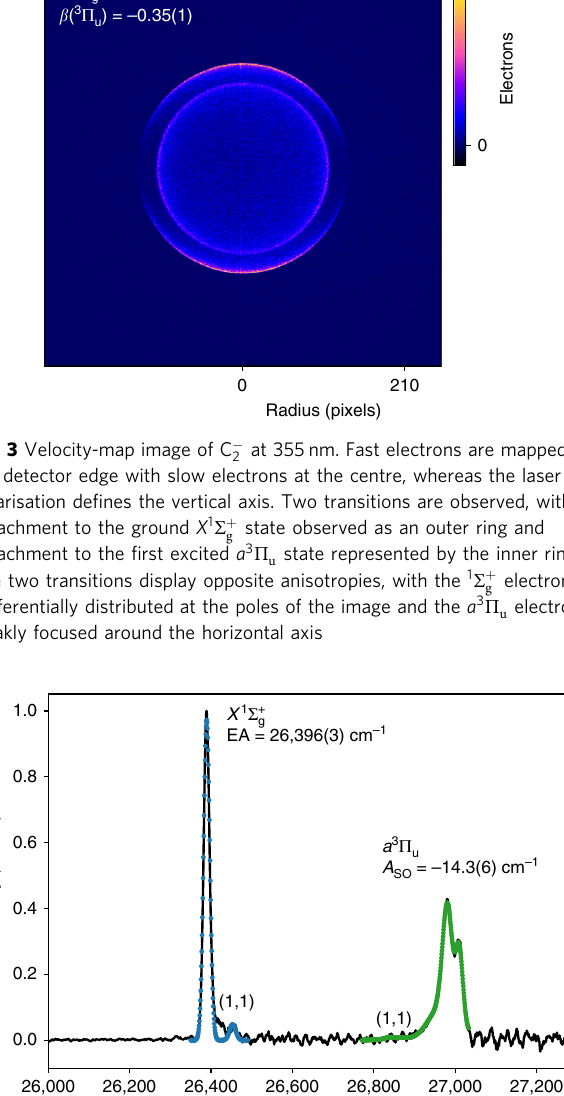
at 355 nm. Two electronic transitions Fig. 4 Photoelectron spectrum of C (cid:1) 2 ð X 2 Σ þ Þ and C a 3 Π ð X 2 Σ þ Þ are observed, C 2 ( X 1 Σ þ ) C (cid:1) ) C (cid:1) 2 ( 2 2 u g g g separated by 612 cm − 1 . The experimental spectrum is shown in black, with a rotational band model ( X X shown in blue, a X shown in green) fi tted to each transition. This highlights the presence of a hot band (1, the ground ( X 1 Σ þ ) and excited ( a 3 Π ) photoelectron transitions, u g respectively, as shown in Fig. 4. The model fi t yields an anion rotational temperature of T = 197(2) K, whereas the Gaussian full- width half-maximum of each transition gives an energy resolution ¼ 15 ð 1 Þ cm − 1 and Γ ¼ 18 ð 1 Þ cm − 1 , which are consis- of Γ X 1 Σ a 3 Π tent with expectations for the spectrometer at electron kinetic energies of ϵ (cid:4) 0 : 3 eV.